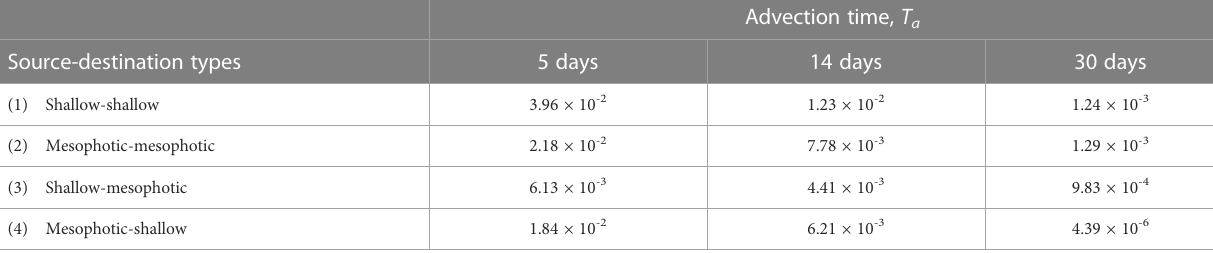
TABLE 2 Three-dimensional connectivity between two depth zones at the advection times T a of 5, 14, and 30 days.